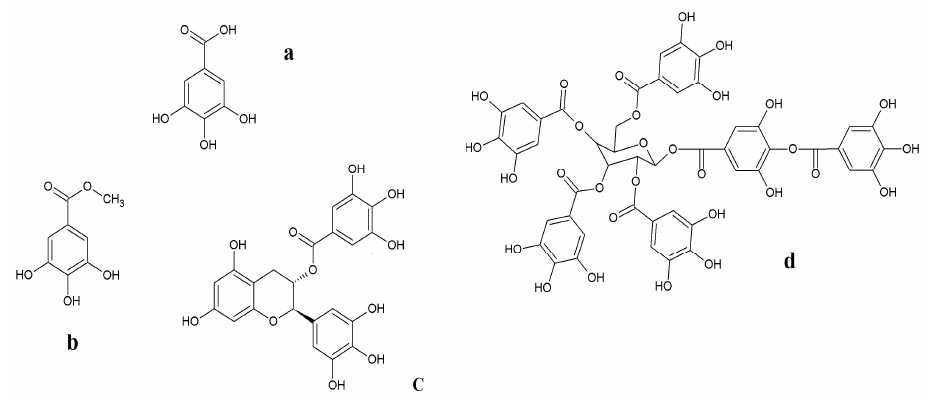
Figure 1. Chemical structure of gallic acid ( a ) and its derivatives: gallic acid methyl ester ( b ), (-)-epigallocatechin gallate ( c ), and hydrolysable tannin ( d ).